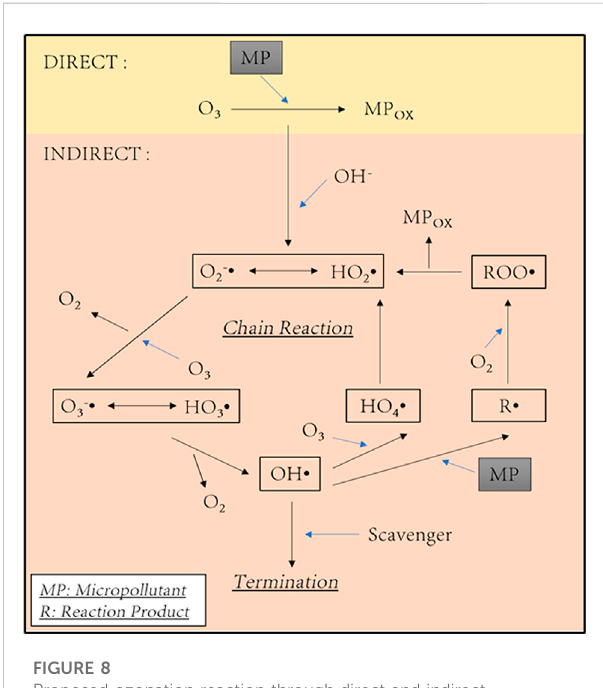
FIGURE 8 Proposed ozonation reaction through direct and indirect approaches.